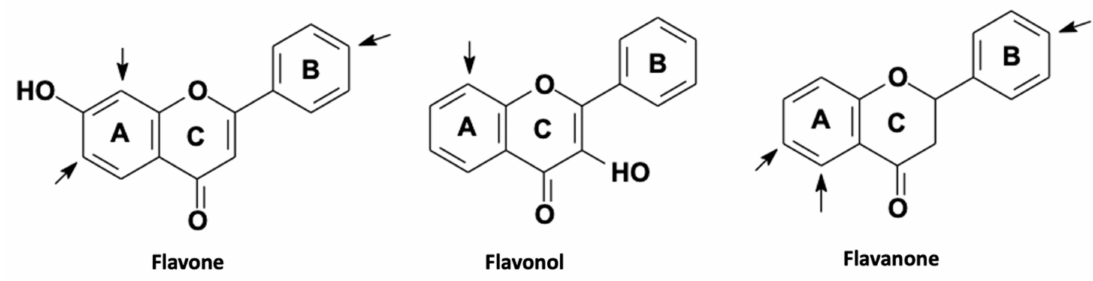
Figure 4. Hydroxylation sites of the main flavonoids compounds that can be modified by microorganismsduringfermentation.